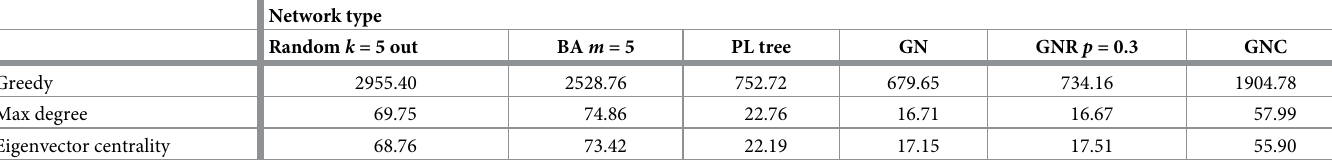
Table 2. Computation time (sec) in different network types under budget k =